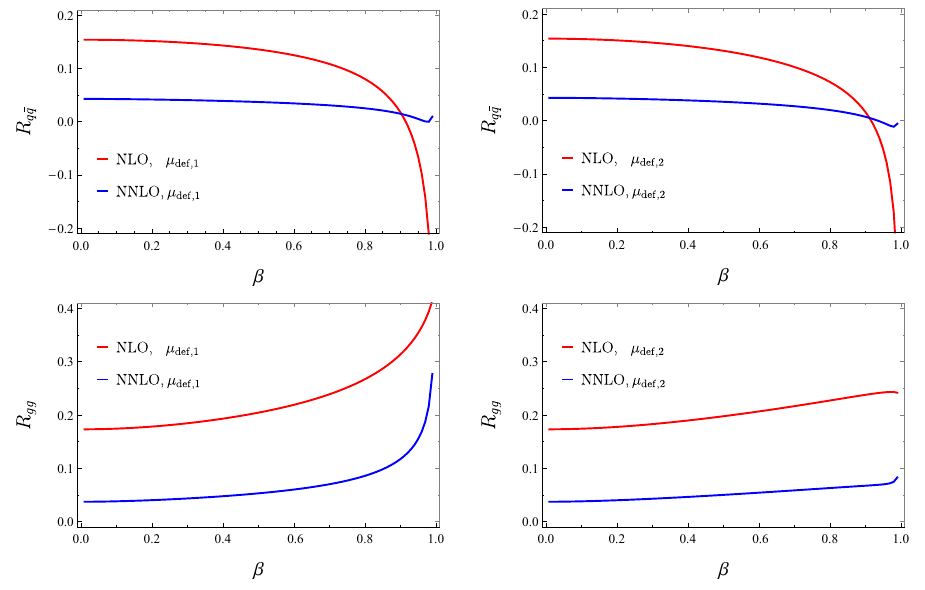
Figure 8 . Relative soft corrections as a function of β for two choices of the default scale: µ def , 1 = Λ 1 β 2 cos 2 θ (left) and µ def , 2 = Λ − p